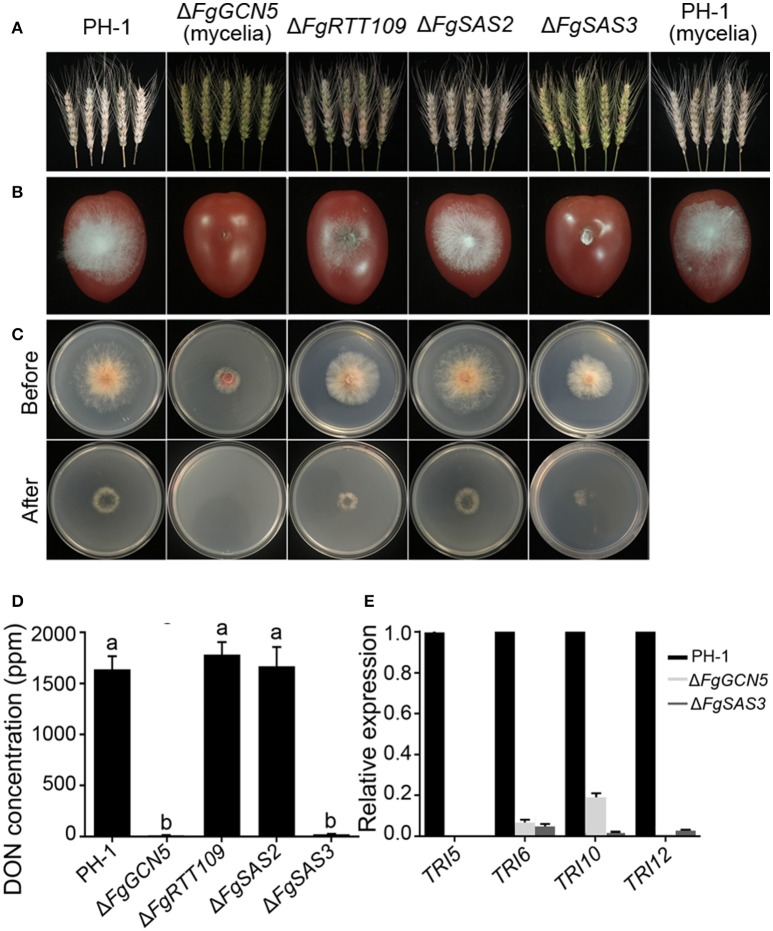
Comparison of virulence, DON production and the relative expression levels of selected trichothecene genes in PH-1 and the deletion mutants. (A) Pathogenicity on flowering wheat heads. Flowering wheat heads were point inoculated with a conidial suspension at 106 conidia/mL of the wild type strain PH-1, ΔFgRTT109, ΔFgSAS2, and ΔFgSAS3. In the case of ΔFgGCN5, a mycelial suspension was used to inoculate wheat ears. Infected wheat heads were photographed 2 weeks after inoculation. (B) Pathogenicity on cherry tomato fruits. Cherry tomatoes were inoculated with a conidial suspension at 106 conidia/mL of PH-1, ΔFgRTT109, ΔFgSAS2, and ΔFgSAS3. A mycelial suspension of ΔFgGCN5 was inoculated into cherry tomatoes. Fruits were photographed 3 days after inoculation. (C) Penetration of PH-1 and four deletion mutants through cellophane membrane. Fungal colonies were grown for 2 d at 25°C on top of a cellophane membrane placed on minimal medium (MM) and were photographed (Before). The cellophane membranes with the fungal colonies were removed, and the plates were incubated an additional 24 h to examine the presence of mycelial growth on the plates (After). (D) DON production byΔFgGCN5, ΔFgRTT109, ΔFgSAS2, and ΔFgSAS3 mutants compared with the wild type. The amounts of DON produced by each strain were determined after 7 days of inoculation into TBI liquid medium. Line bars in each column denote standard errors of three replicated experiments. Values on the bars followed by the same letter are not significantly different at P = 0.05. (E) Relative expression levels of TRI5, TRI6, TRI10, and TRI12 in the wild-type PH-1, ΔFgSAS3 and ΔFgGCN5 assayed by qRT-PCR. The relative expression levels of TRI genes in ΔFgSAS3 and ΔFgGCN5 are the relative amounts of cDNA of the gene in the wild-type progenitor. Line bars in each column denote standard errors of three repeated experiments.